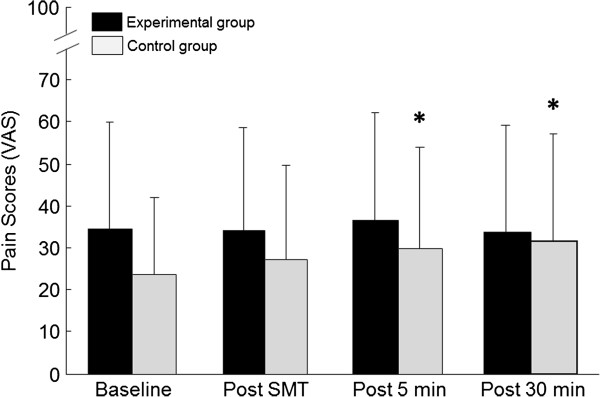
Mean baseline and post spinal manipulation pain scores (VAS = 0–100) for both the control and experimental groups. *Pain in the control group significantly increased at the 5 min and 30 assessments when compared to baseline value. Whiskers indicate standard deviation.